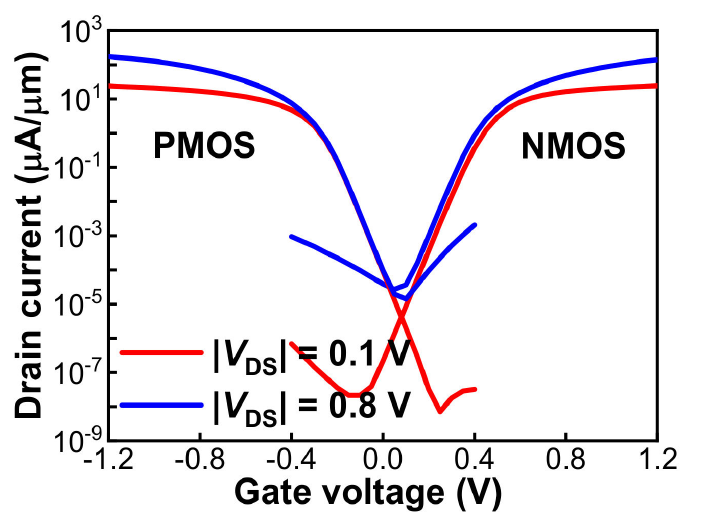
Figure 6. I DS - V GS characteristics of low-temperature complementary Schottky S/D FinFETs with L G = 500